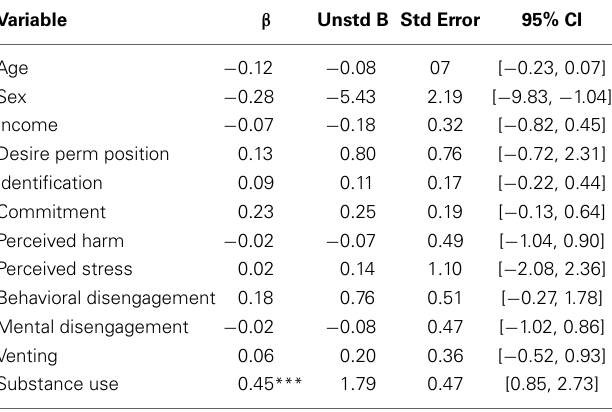
Table 9 | Standard multiple regression predicting depression.